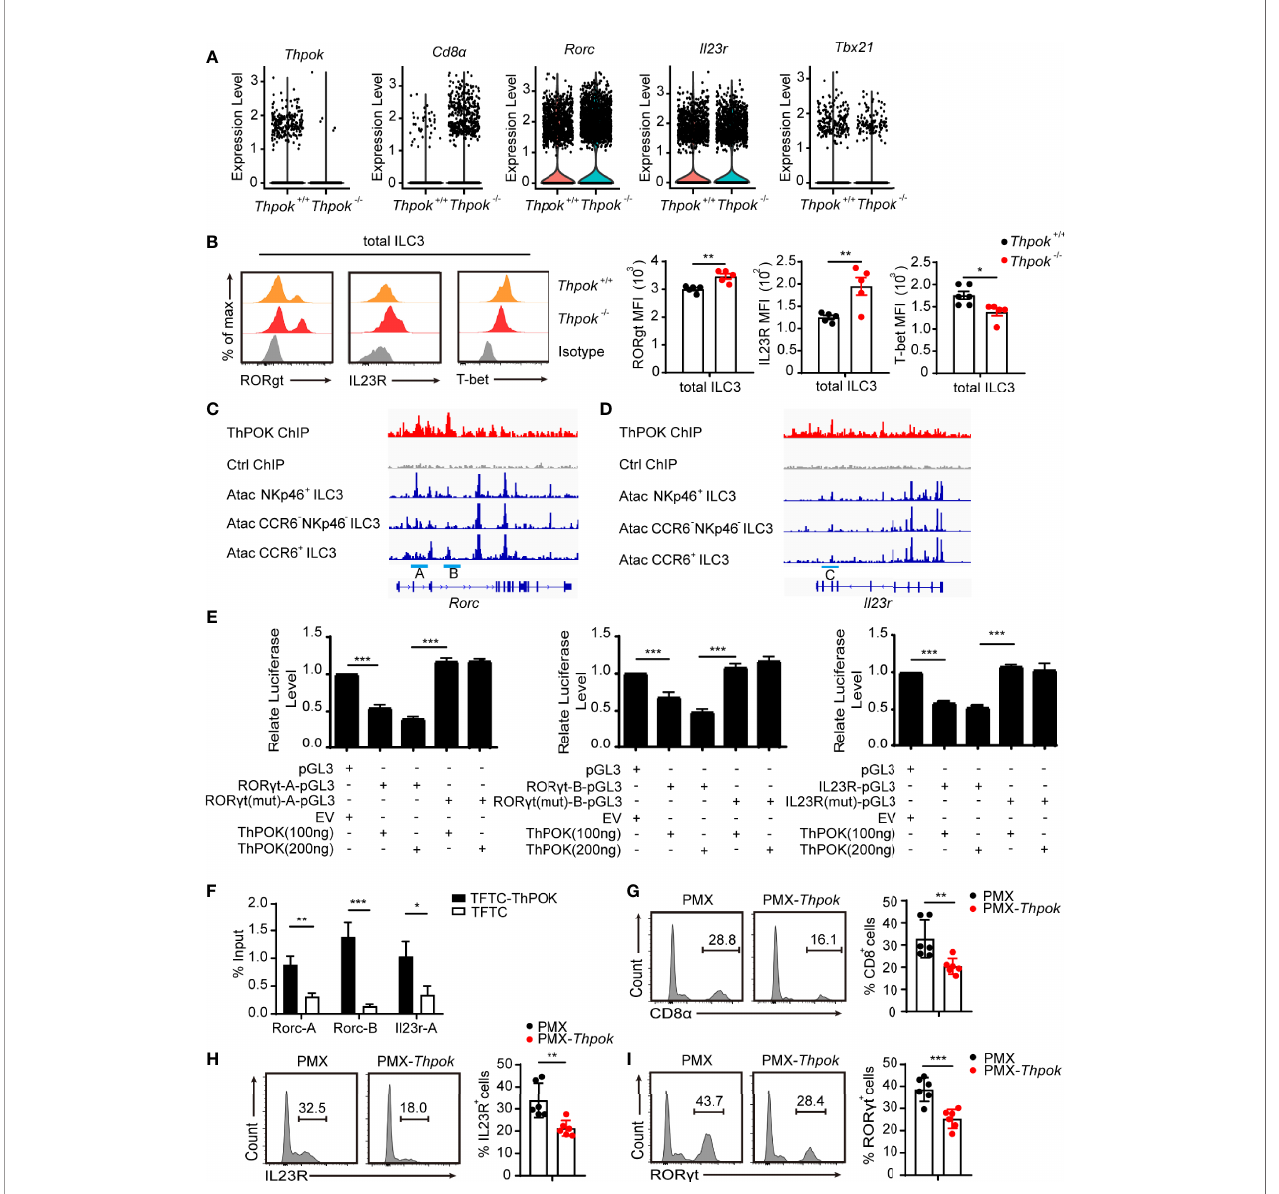
FIGURE 6 | ThPOK negatively regulates the expression of ROR g t and IL23R. (A) Violin plots showing differential expression of several ILC3 key genes. (B) Overlaid histograms (left) show expression of indicated protein in ThPOK-de fi cient mice (red), control mice (yellow) and Isotype (grey). Graphs (right) show MFI of protein expression. (mean ± SEM; n = 5; * P < 0.05, Student ’ s t test). (C, D) Graph of the Rorc C . and Il23r gene (D) , bottom tracks show Immgen ATAC-Seq peaks in NKp46 + ILC3s, DN ILC3s, and CCR6 + ILC3s (http://rstats.immgen.org/Chromatin/chromatin.html). Middle tracks show ChIPseq of activated CD4 + T cells from Zbtb7b Bio/+ Rosa26 BirA+ (Thpok), or Zbtb7b +/+ Rosa26 BirA+ (Ctrl) mice. (E) Luciferase activity in HEK293 cells transfected with various combinations (below plot) of vector alone (pGL3) or with 100, or 200 ng of vector containing the WT promoter of Il23r , Rorc or with mutations in the ThPOK-binding site of the promoter, together with empty vector (EV) or vector expressing ThPOK (ThPOK). The results are presented relative to cells transfected with pGL3 and empty vector (far left), set to one. (mean ± SEM; n = 6-9; *** P < 0.001, Student ’ s t test). (F) ThPOK binding at the Il23r and Rorc locus in EL4 stable cell lines expressing either a triple fl ag peptide (TFTC) or triple- fl ag-tagged ThPOK (TFTC-ThPOK) was monitored using a fl ag ChIP assay. The fold enrichment of ThPOK binding at each locus was normalized to TFTC-empty EL4 cells. (mean ± SEM; n = 6-9; * P < 0.05, ** P < 0.01, *** P < 0.001, Student ’ s t test). (G – I) ILC3s were sorted from WT and ThPOK-de fi cient mice and infected with retrovirus containing the indicated vector. Flow cytometry for CD8, IL-23R and ROR g t expression in ILC3s with the indicated vector overexpressed. (mean ± SEM; n = 6; ** P < 0.01, *** P < 0.001, Student ’ s t test). Data are representative of at least three independent